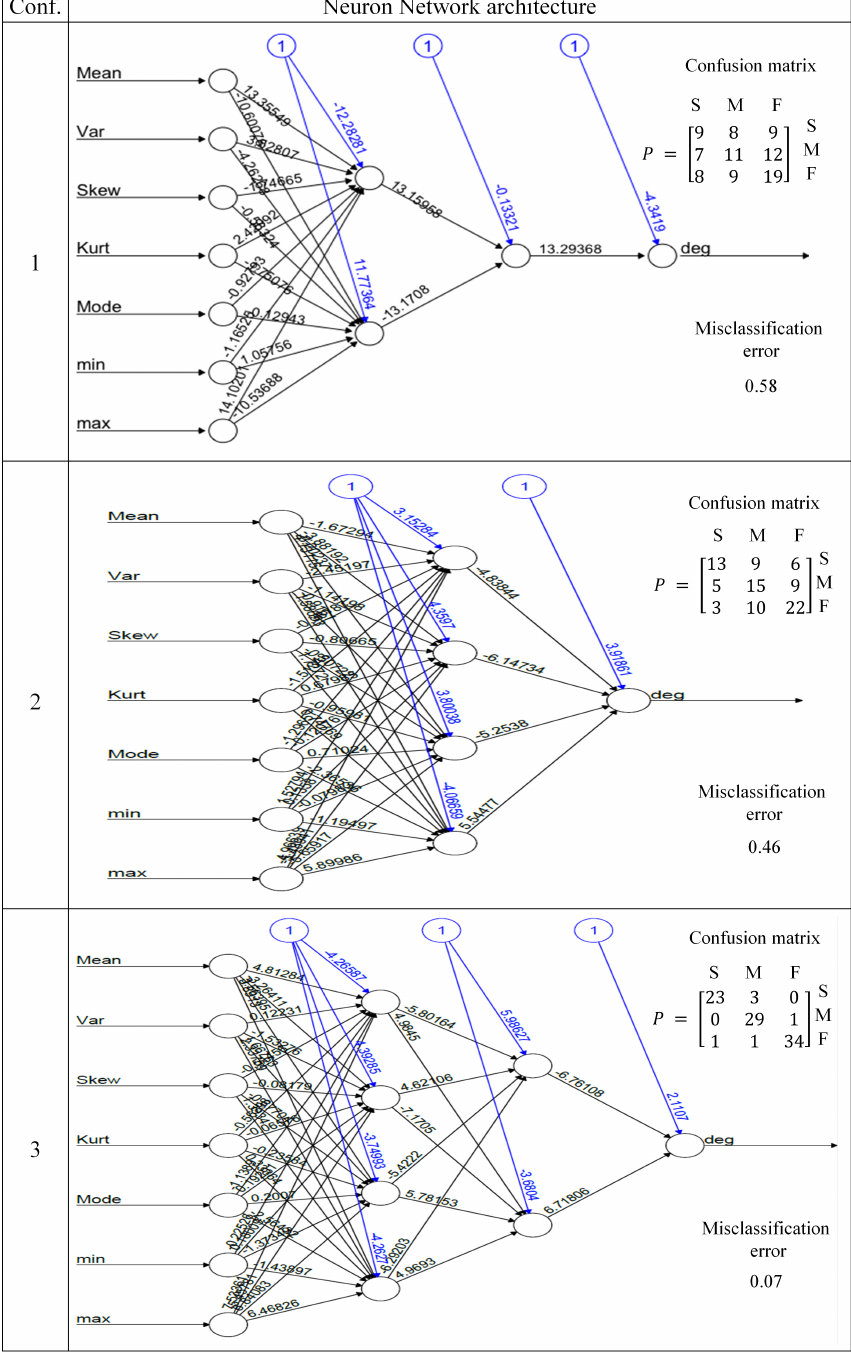
Figure 9. NN classification results for simulated data (S—Slow, M—Moderate, and